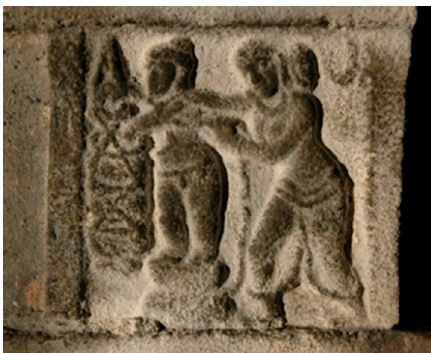
Figure 11. K ṛṣṇ a climbed upon the mortar, Ya ś od ā comes to punish him, end of the ninth–beginning of the 10th century. Granite. Tiruva ṭ utu ṟ ai, Tamil Nadu.